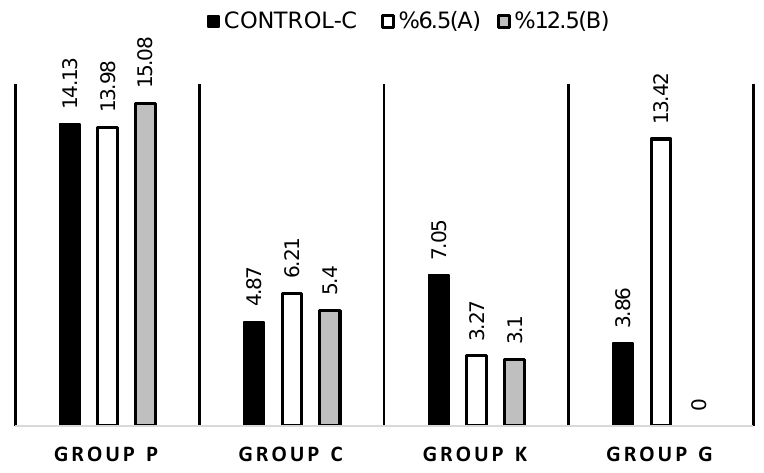
Figure 2. Median scores for different cements at different concentrations.